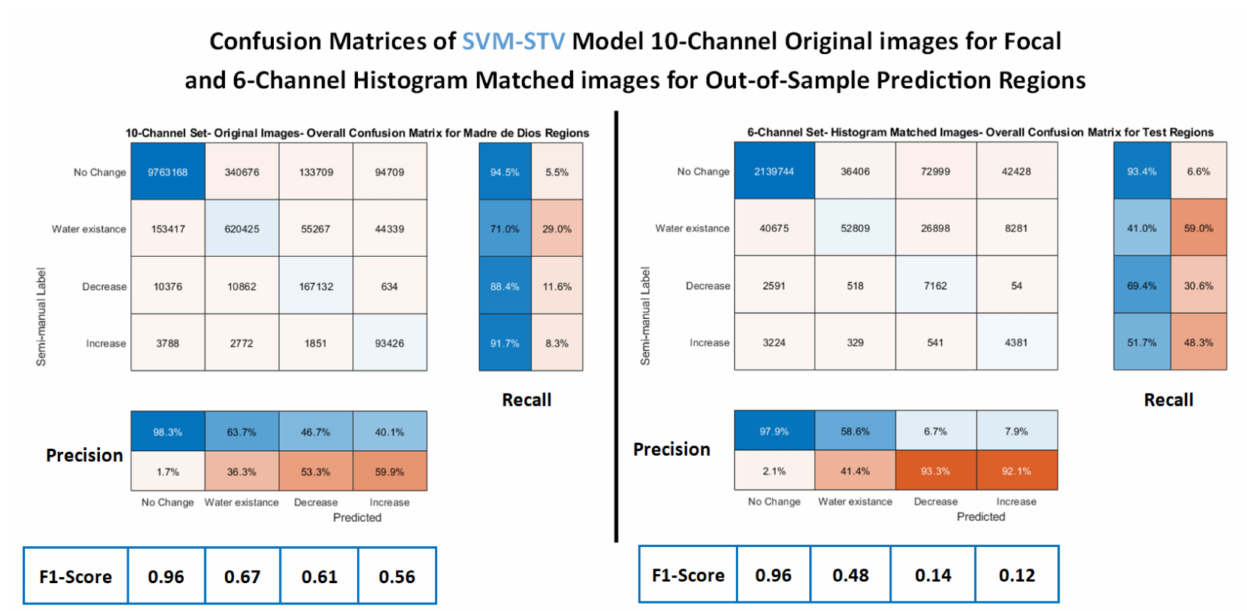
Figure 7. Confusion matrices for the E-ReCNN model for 6-Channel set histogram-matched images from the MDD focal regions ( left ) and out-of-sample prediction regions ( right ). For both ( left ) and ( right ), recall and precision matrices are featured to the right and below the main confusion matrix, respectively. Arrays at the bottom of both ( left ) and ( right ) show the F1-score for each class.